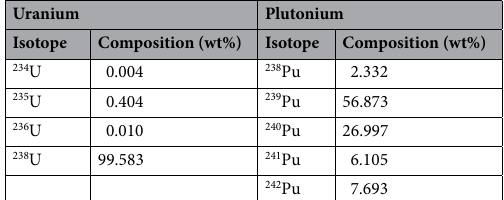
Table 1. The isotopic of LFR fuel used in the